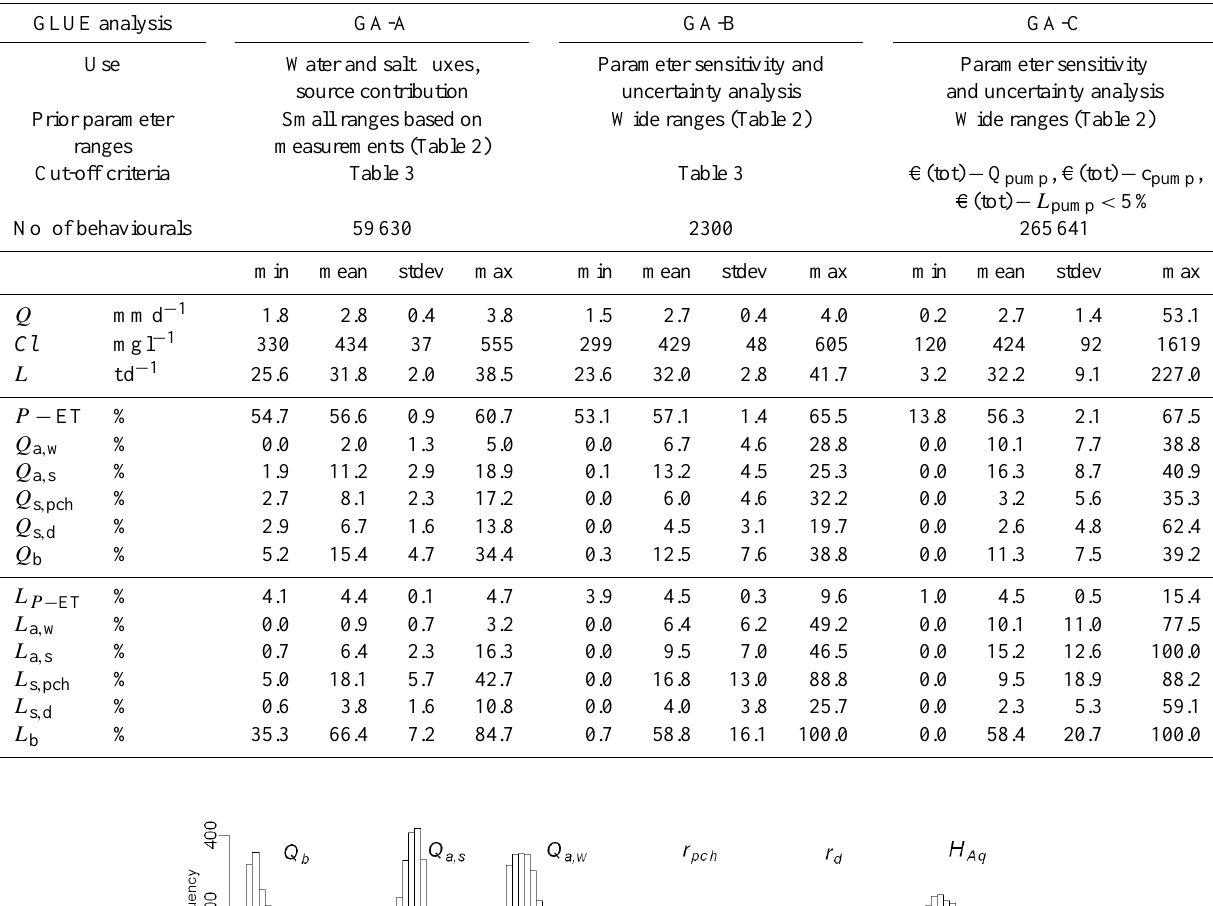
Table 4. Uncertainty ranges for three GLUE analyses with different prior parameter distributions ranges and cut-off criteria. The uncertainty ranges are represented by the statistics of the entire ensemble of daily simulated discharge Q , concentration Cl and salt load L and by the quantified source contribution to total polder water discharge and salt load in %.